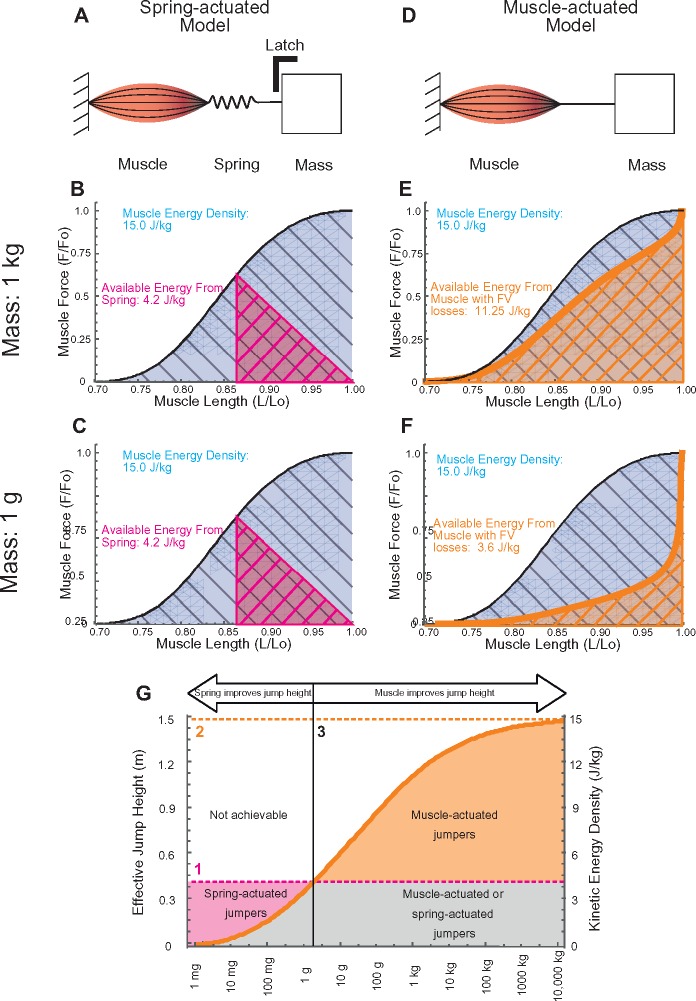
Two mathematical models compared the energetic costs and consequences of spring-actuated versus muscle-actuated jumps across animal sizes. In the spring-actuated model (A), the energy density of the muscle (J/kg), based on the integration of the muscle’s length–tension curve) is shown in blue and the energy density that could be stored in the spring (J/kg) is shown in magenta. Two example simulations are shown: a 1 kg spring-actuated system (B) and a 1 g spring-actuated system (C). As the system changes in size, the available energy density of the muscle does not change, and neither does the energy density of the spring, causing spring-actuated systems to store 28% of the available muscle energy—no matter the size of the mass. Consequently, jump height in spring-actuated systems is independent of size. The ratio of energy imparted to the mass (output energy, magenta) and energy available from the muscle (input energy, blue) is shown as a function of mass for spring-actuated systems in Fig. 1G (magenta dotted line). In the muscle-actuated model (D), the energy (in J/kg) available from the muscle is likewise shown in blue for a 1 kg (E) and a 1 g (F) mass simulation. The energy output versus length (the energy that accelerates the mass) is shown in orange. As the mass gets smaller, force–velocity properties reduce the muscle force, thus decreasing the output energy in the system, thus reducing the amount of energy that accelerates the mass. For the range of masses simulated, the effect of size on output energy (the energy that accelerates the mass) is shown by the orange solid line in Fig 1G. This reaches an asymptotic maximum possible jump height shown by the orange dashed line (2). Dashed lines 1 and 2 thus represent the alternative maximum jumping heights for spring-actuated and muscle-actuated jumpers, respectively. A size-related “crossover point” is evident (G, black line 3), such that animals smaller than this point can jump higher with a spring-actuated mechanism, whereas animals larger than this point can jump higher with a muscle-actuated mechanism.